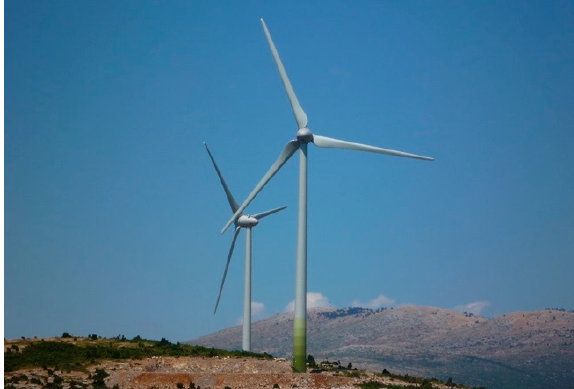
Figure 1. View of two turbines of the park analyzed in the study.